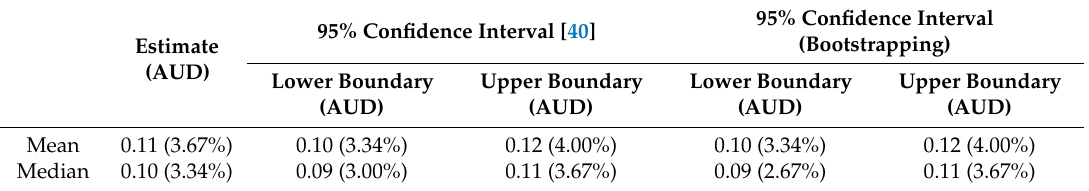
Table 3. Consumers’ willingness to pay estimates and confidence intervals in Australian dollars (AUD) for a box of cookies with the Health Star Rating on the front of the pack, where a box without the Health Star Rating costs AUD 3.00.